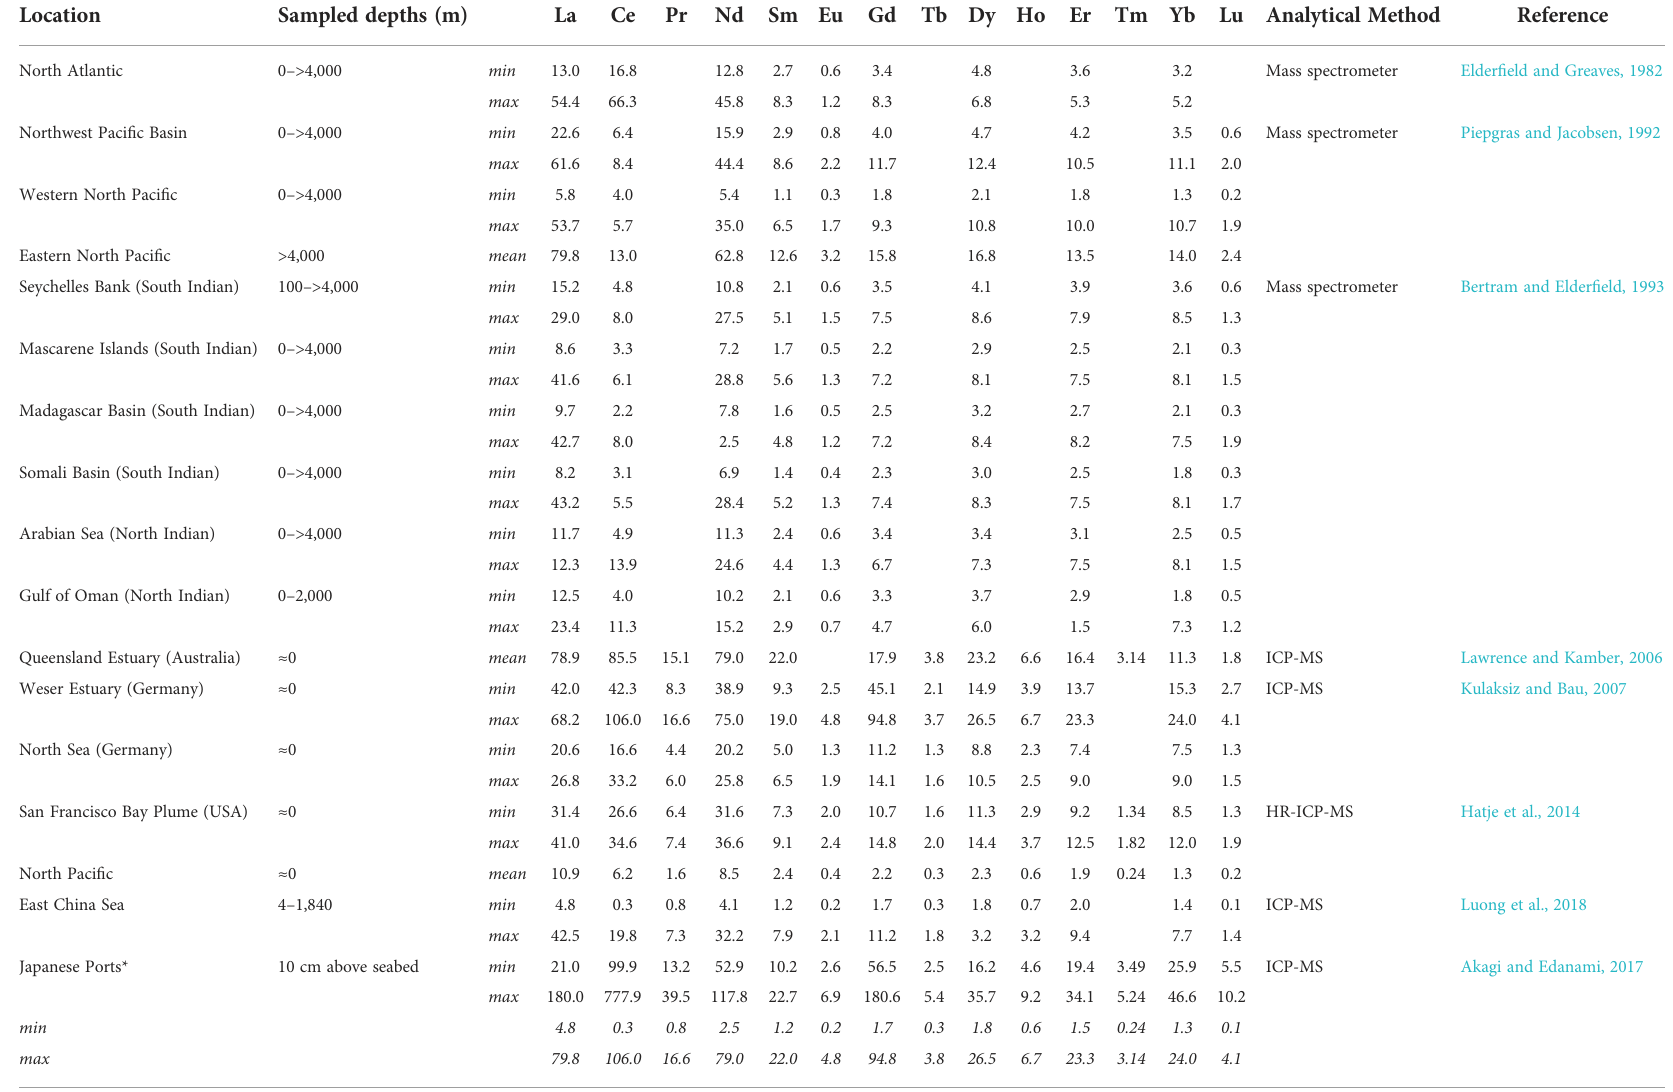
TABLE 1 Minimum and maximum values of REEs (pmol/kg) were observed in different marine waters according to a bibliography revision. Location